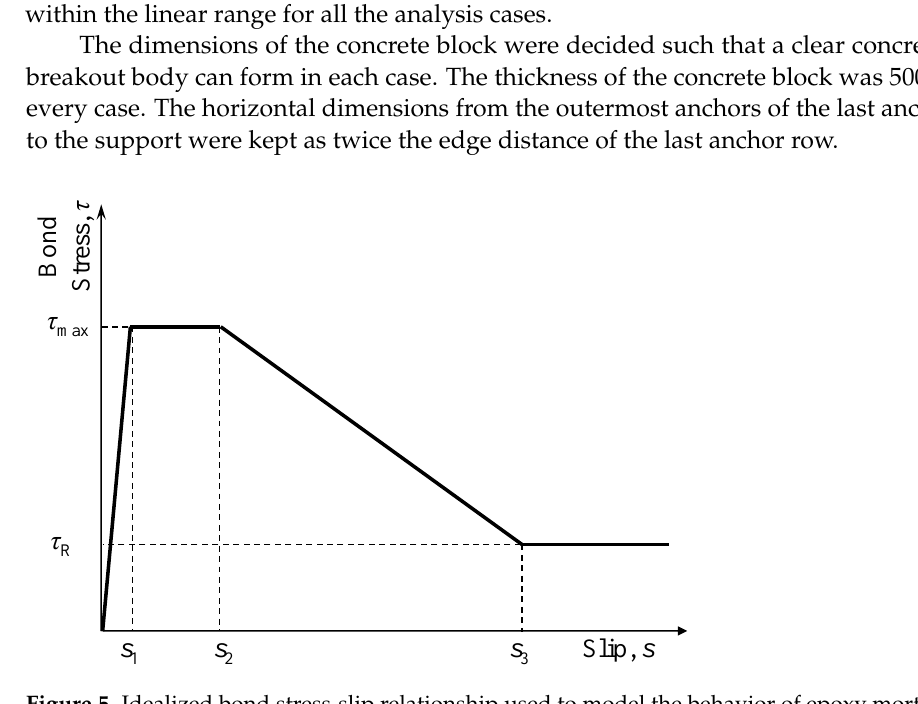
Figure 6. Load-displacement curves obtained for triangular groups from numerical analysis. The numerically obtained failure load of the group TRI-A was 96.8 kN. In compari- son, when the same anchor group is subjected to shear load parallel to the edge, a peak